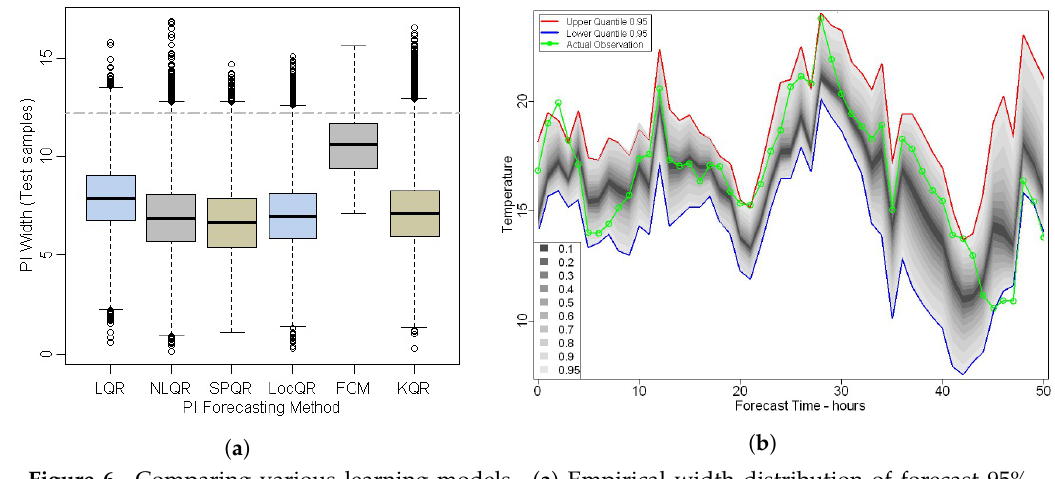
Figure 6. Comparing various learning models. ( a ) Empirical width distribution of forecast 95% PIs—horizontal line shows the best baseline model; ( b ) Trends of various confidence level PIs and the actual observations obtained from Spline-based Quantile Regression (SPQR) models.